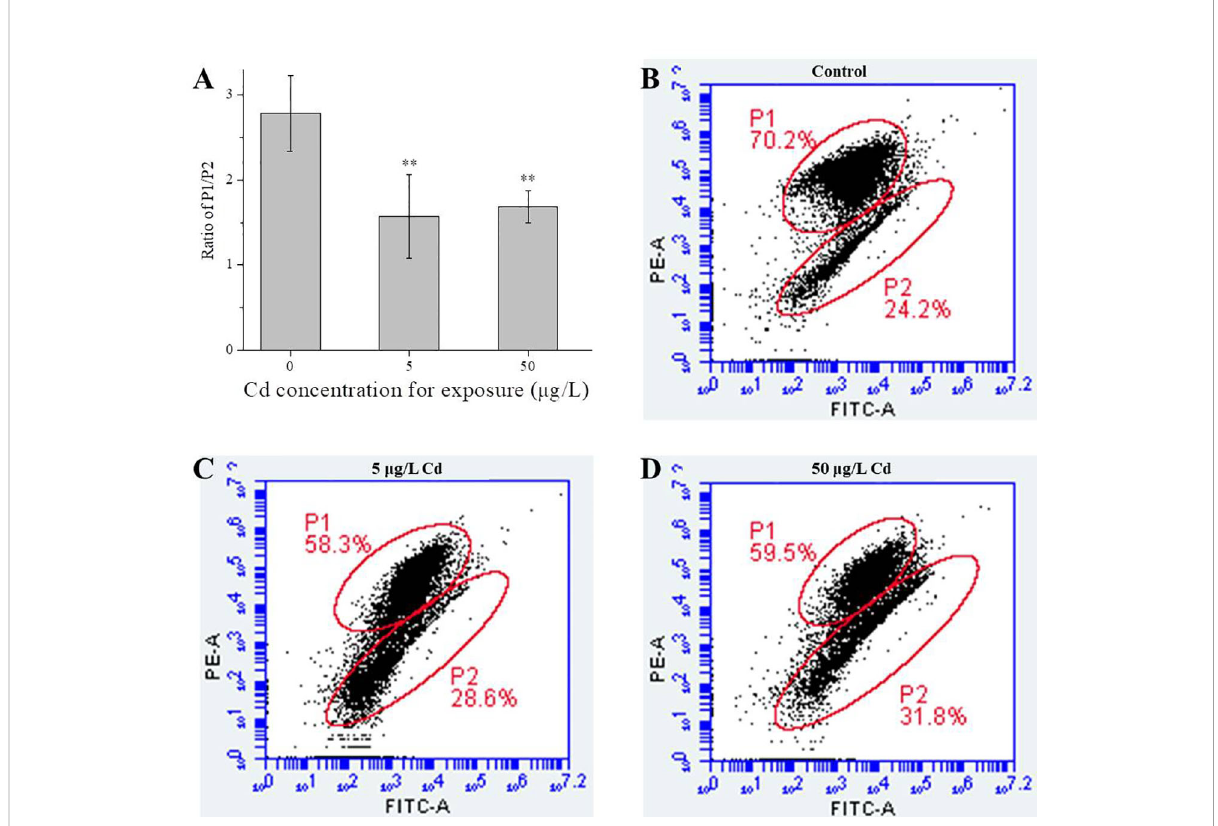
FIGURE 3 MMP changes of liver mitochondria from control and Cd treatments. (A) , ratio of P1/P2 for liver mitochondria ( n = 4). (B – D) typical scatter plots of MMPs detected by FCM. ** represents P <